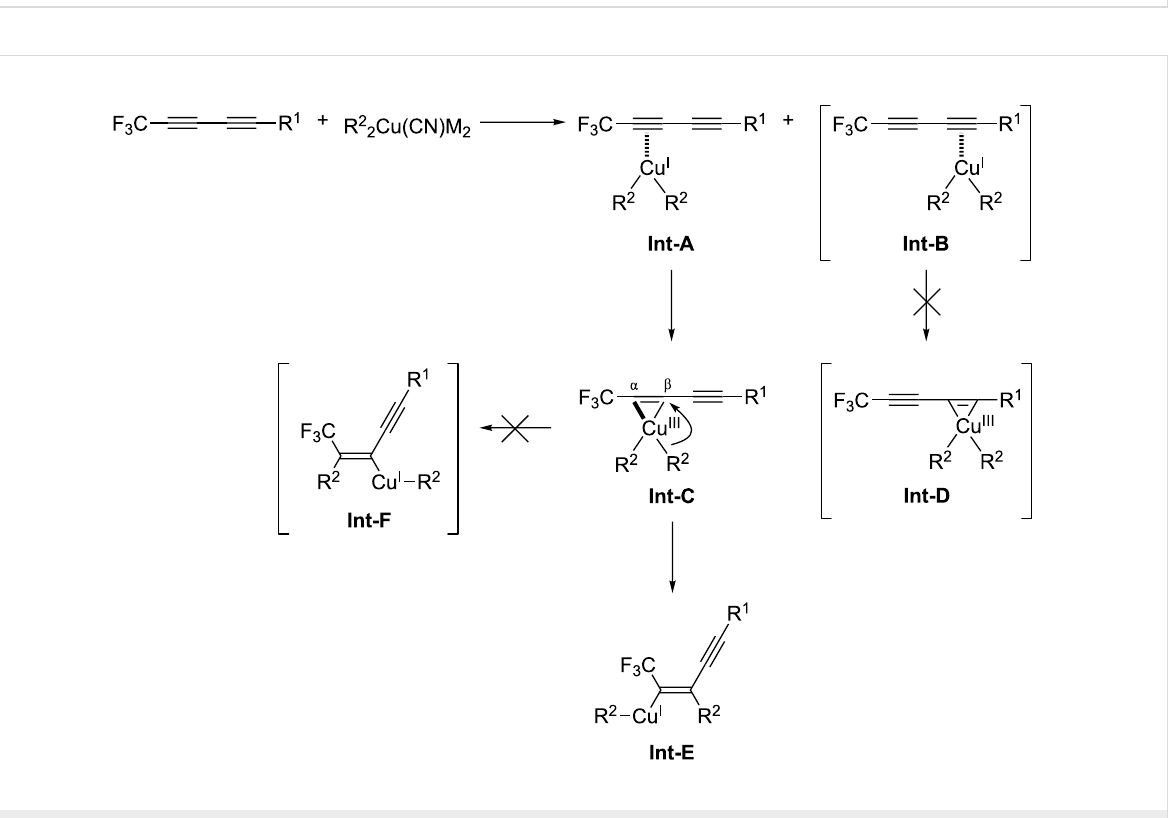
Scheme 3: A proposed reaction